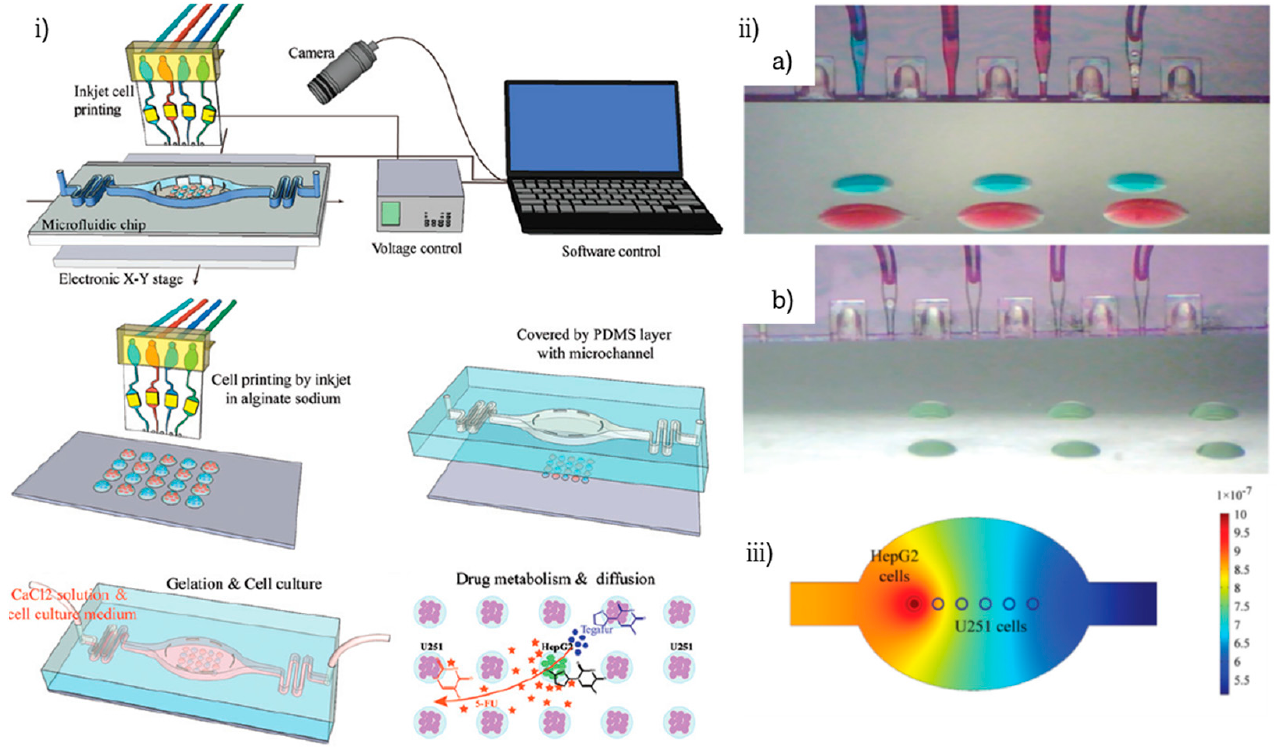
Figure 9. Precise cell patterning for in-chip detection of drug metabolism: ( i ) schematic representa- tion of the experimental setup and process, ( ii ) inkjet printing on (a) hydrophilic and (b) hydropho- bic glass surface, ( iii ) modeling of drug metabolism and diffusion from HepG2 cells to U251 cells in the microfluidic device. Reprinted and edited with permission granted by Copyright Clearance Cen- ter, Inc. (“CCC”). Published in Analyst , by the Royal Society of Chemistry, Vol 141. Authors: J. Zhang et al. Title: “A novel approach for precisely controlled multiple cell patterning in microfluidic chips by inkjet Printing and the detection of drug metabolism and diffusion” [83].